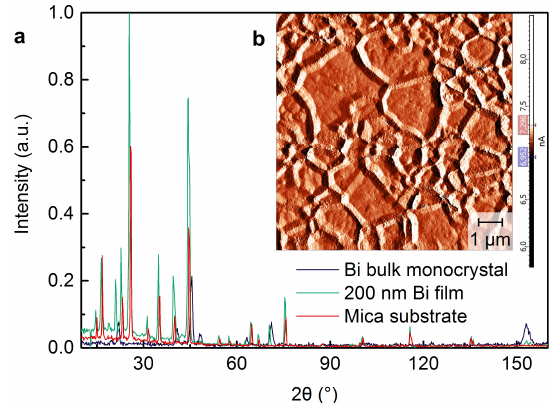
Figure 3. ( a ) X-ray diffraction (XRD) patterns for Bi(111) bulk monocrystal, 200 nm Bi film, and mica substrate. The bifurcated peak at 153 ◦ indicates the (111) film plane crystallographic orientation. ( b ) Atomic force microscopy (AFM) image of a 200 nm Bi film